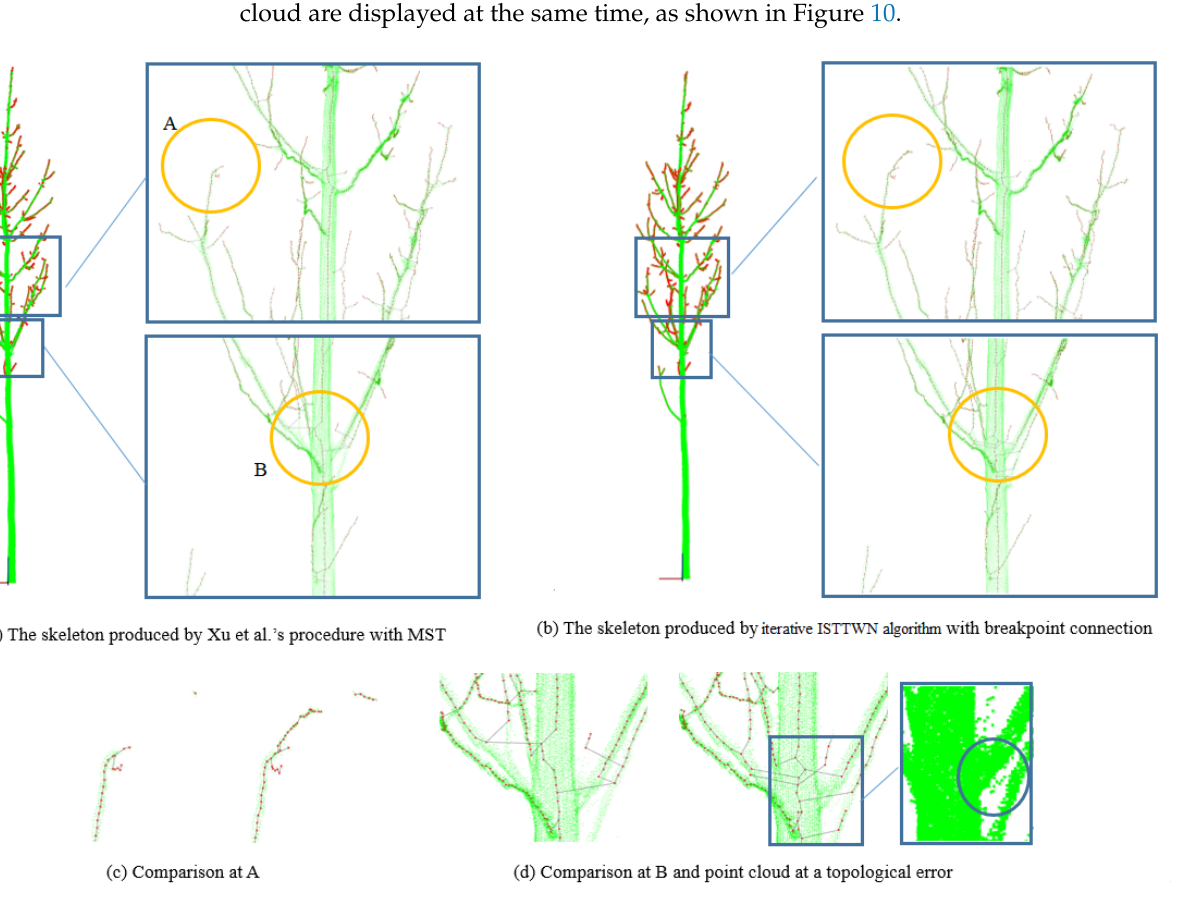
Figure 10. Accuracy comparison of previous and new proposed